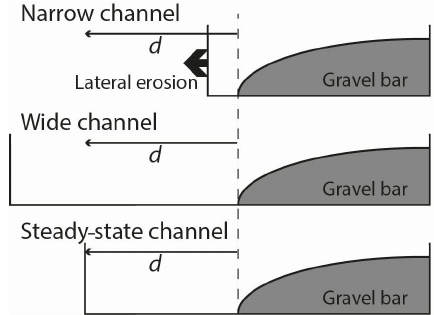
Figure 1. Illustration of how the sideward deflection length scale d and the channel width interact to determine lateral erosion. The dashed vertical line shows the relevant deflection point within the cross section. Top: in a narrow channel, particles that are laterally deflected a distance d may hit the wall and cause erosion. The chan- nel widens. Centre: in a wide channel, the deflected particles do not reach the wall. No lateral erosion occurs. Conversely, few par- ticles travel over the bedrock bed near the wall. Sufficient tools to drive the vertical erosion of the bed are only available within the distance d of the deflection point. An inner channel with the steady- state width is formed. Bottom: in a steady-state channel, the channel walls are just out of reach of the deflected particles.